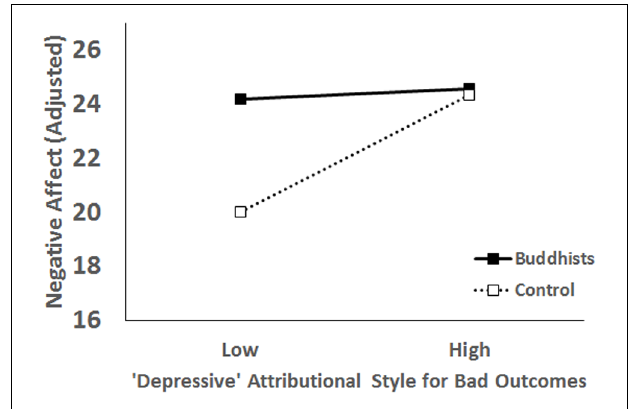
FIGURE 3 | Interaction effect of the depressive attributional style and Buddhist beliefs on negative